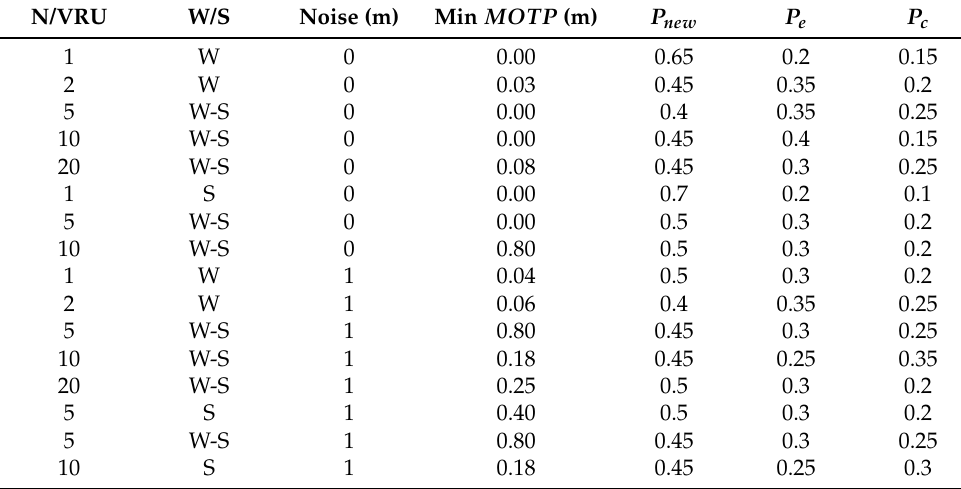
Table 1. Probabilities sets that cause the minimum MOTP for each scenario.